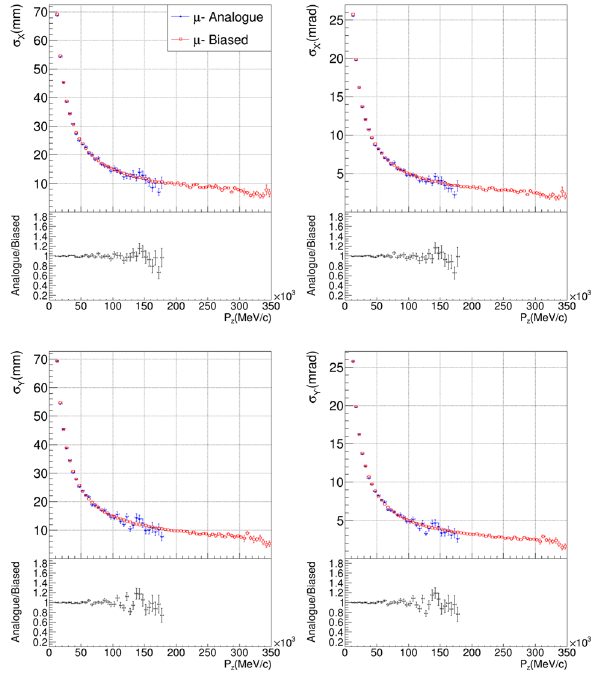
Fig. 5 Same as in Fig. 4, but for negative